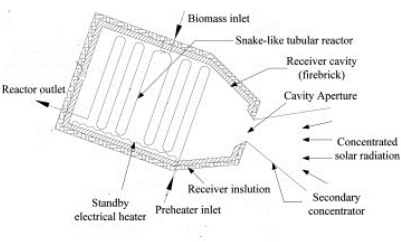
Figure 3. Schematic representation of the “snake-like” tubular reactor/receiver for biomass gasification with supercritical water proposed by Chen et al. Modified from [23] with permission from Elsevier.